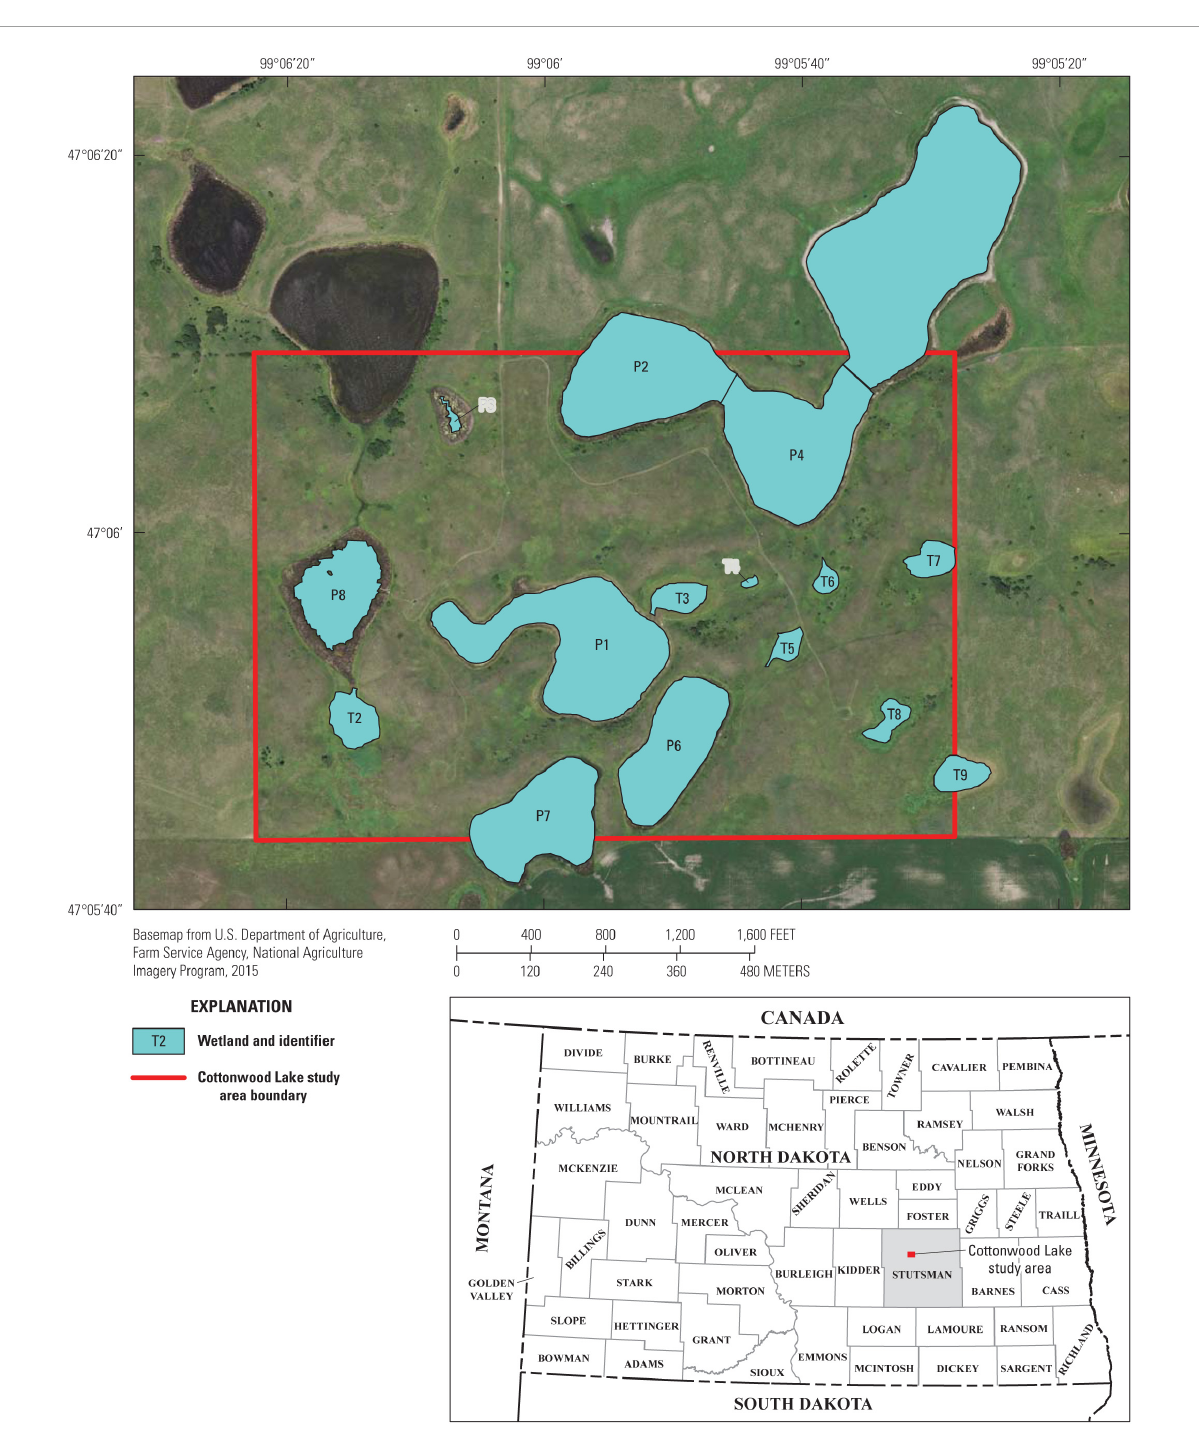
FIGURE1 Map of prairie-pothole wetlands in the Cottonwood Lake study area, Stutsman County, North Dakota (from McKenna et al., 2017). Wetland P-11 (not shown) is located 3.2 km west of the core study area depicted here.